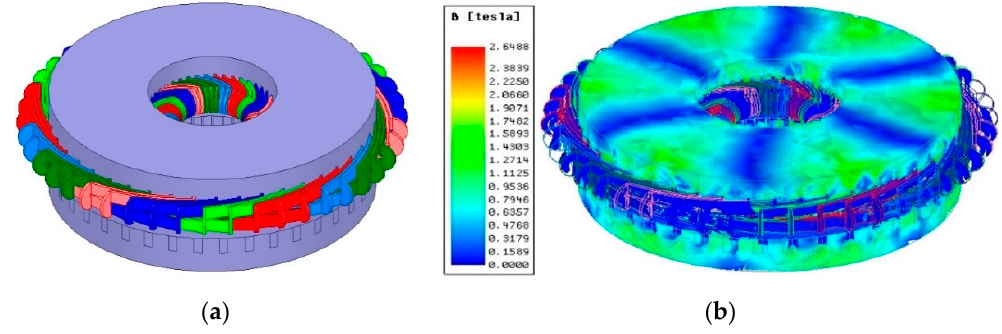
Figure 4. ( a ) AFIM model ( b ) Magnetic field density of AFIM. Table 3. General design parameters of Axial Flux Induction Motor (AFIMs).